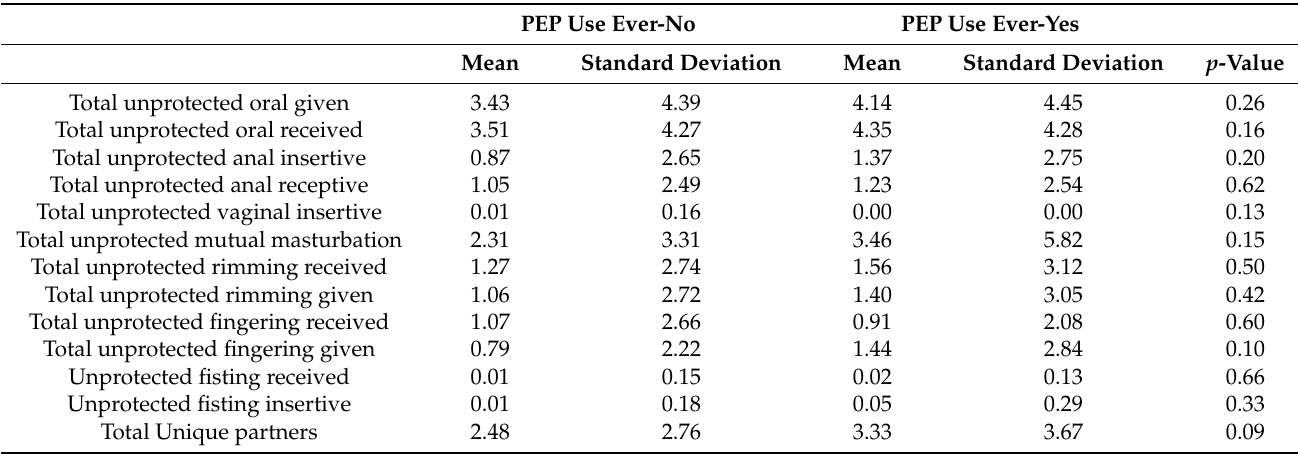
Table A1. Unprotected Sexual Behavior by PEP